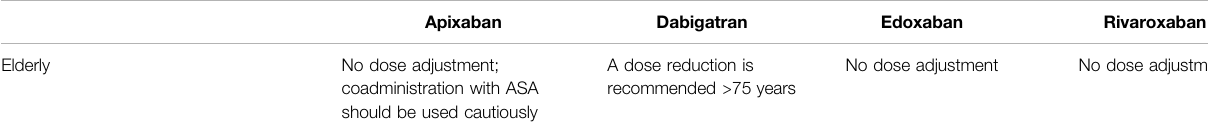
TABLE 4 | Schematic presentation of practical recommendation for clinical DOACs ’ use in speci fi c